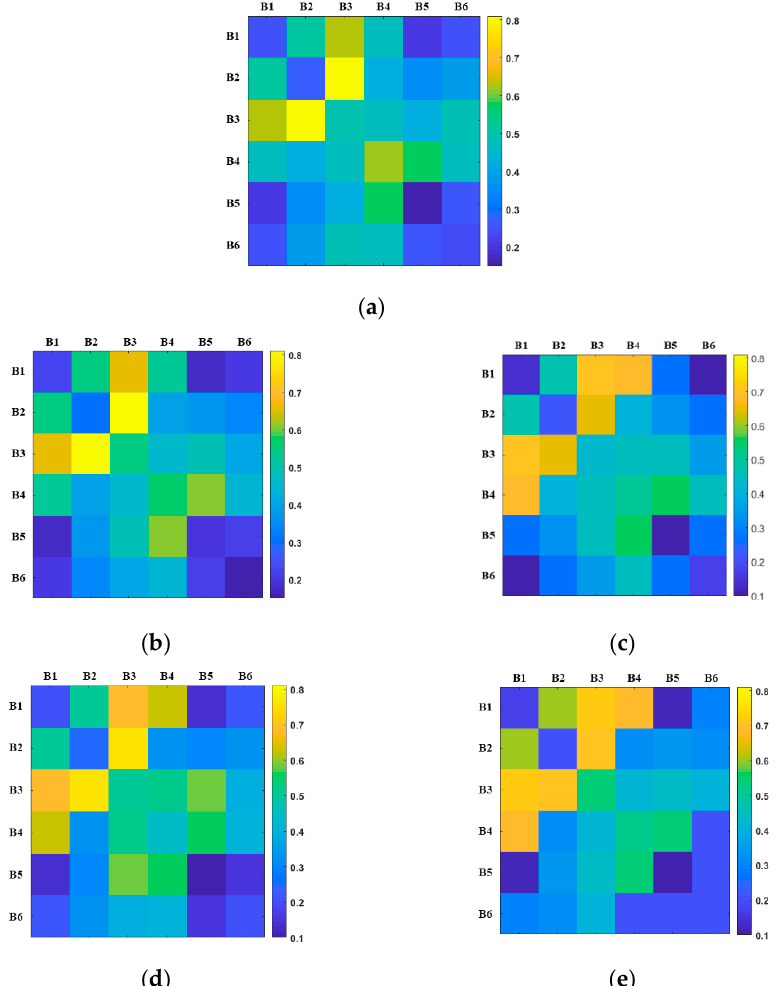
Figure 6. The correlation coefficient matrix of NH 3 -N with bands and band combinations. The X and Y axes are respective bands of images: ( a ) the original Landsat image; ( b ) the fused image based on the SR-FSDAF method. ( c ) Fused image based on the STARFM method. ( d ) Fused image based on the SRCNN embedding method. ( e ) Fused image based on the FSDAF method. Relation of R > 0.5 is significant at the 0.01 level.